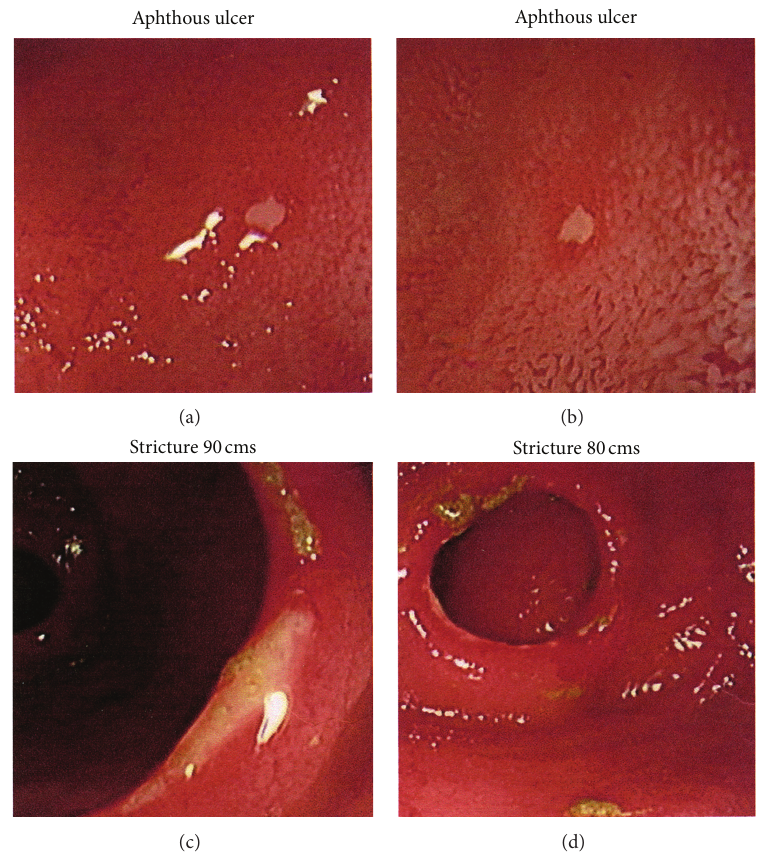
Figure 2: Pouchoscopy/ileoscopy showing aphthous ulcer and nontraversable stricture proximal to ileoanal